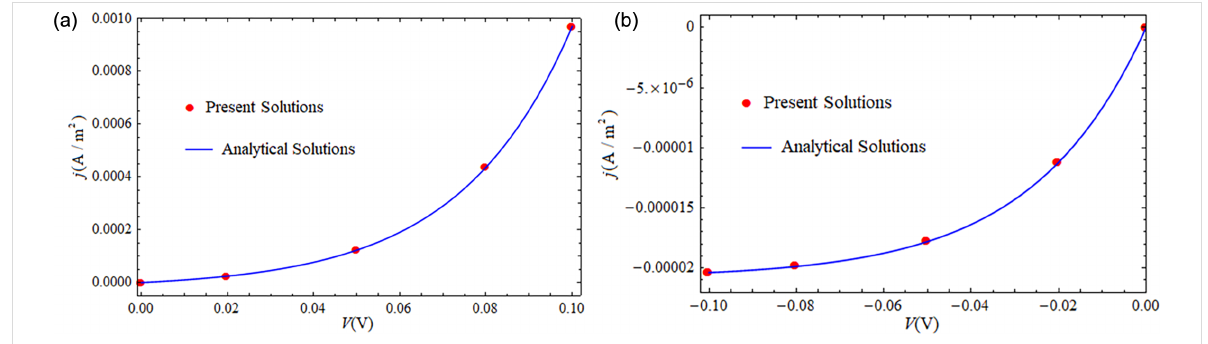
Figure 3: Comparison of I – V characteristics obtained from our model and the Shockley model under (a) forward-bias voltages; (b) reverse-bias volt- ages.